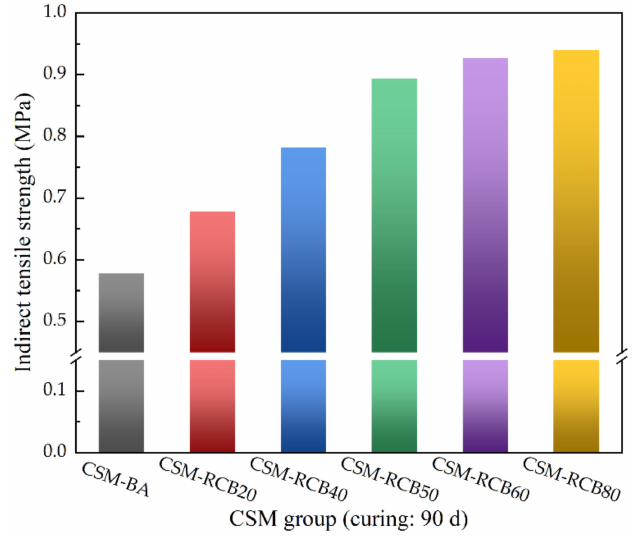
Figure 8. The indirect tensile strength results of